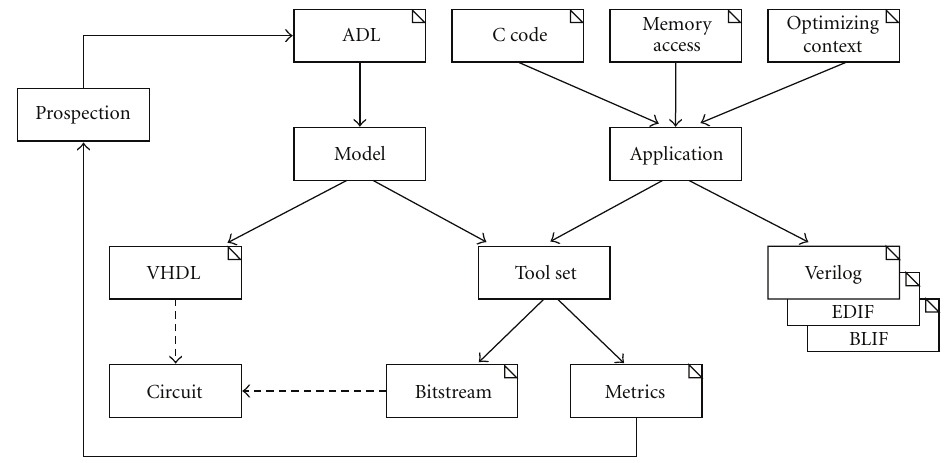
Figure 1: Overview of the Biniou